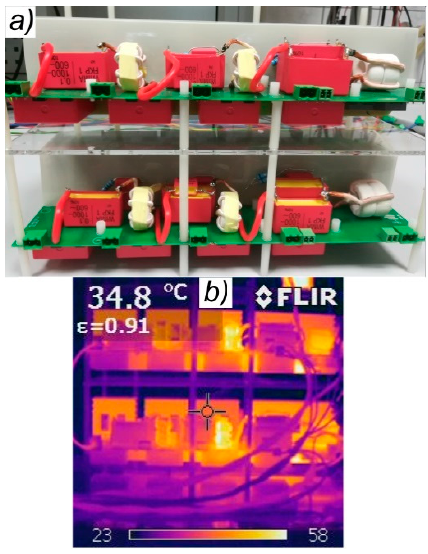
Figure 8. ( a ) Picture of the MRSCC laboratory back-to-back setup ( b ) IR (Infrared) picture under full load (5 kW)—both SiC design.